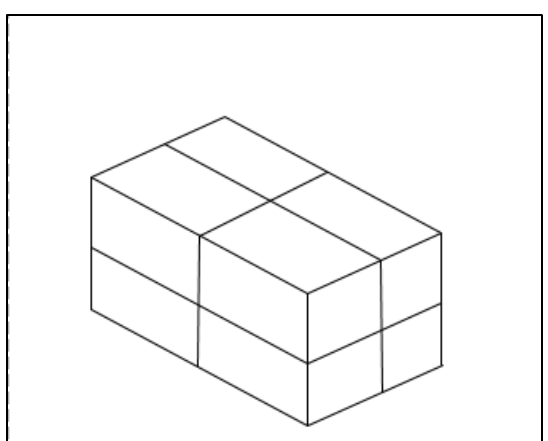
Figure 4. Flashlight stacking model.